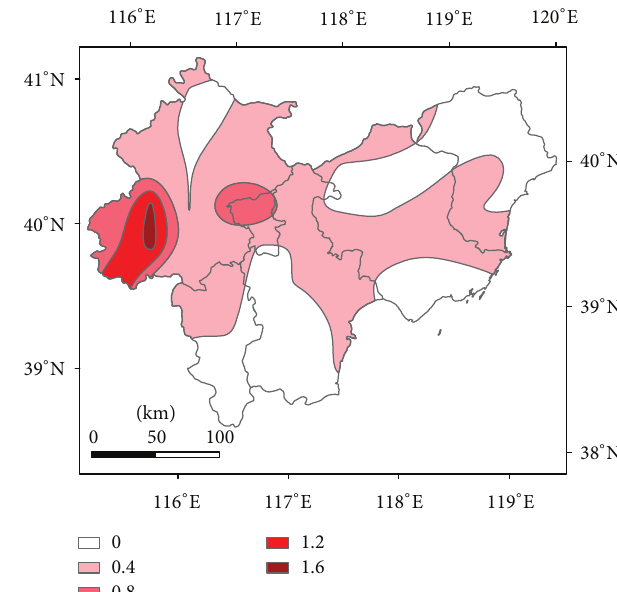
Figure 3: Projected summer temperature difference of monthly average temperature between control test and sensitivity test in Beijing-Tianjin-Tangshan Metropolitan area,